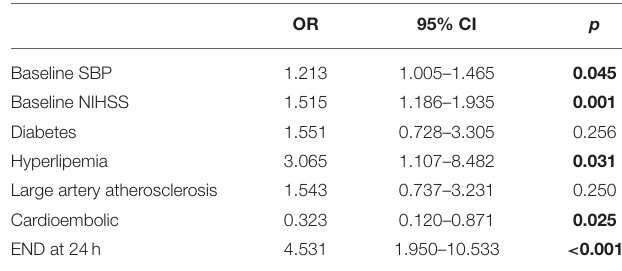
TABLE 4 | Binary logistic analysis of risk factors of functional outcome at 3 months after